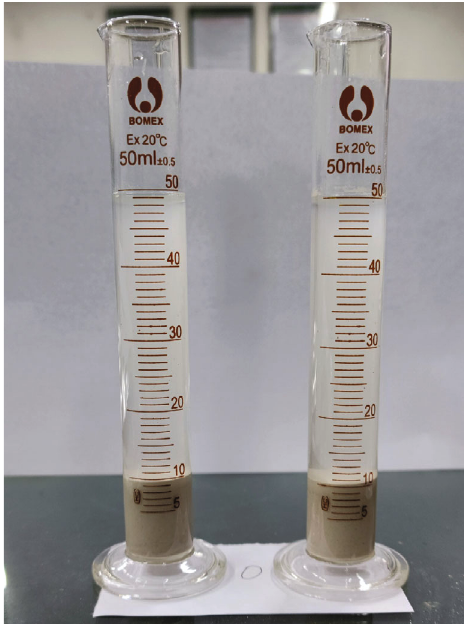
Figure 8: After Expansion. Figure 7: Before